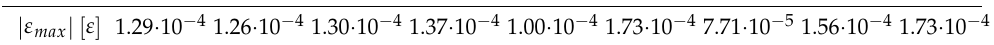
Table 1. Maximum absolute strain values for each sensor installed onto the specimen. Sensor G1